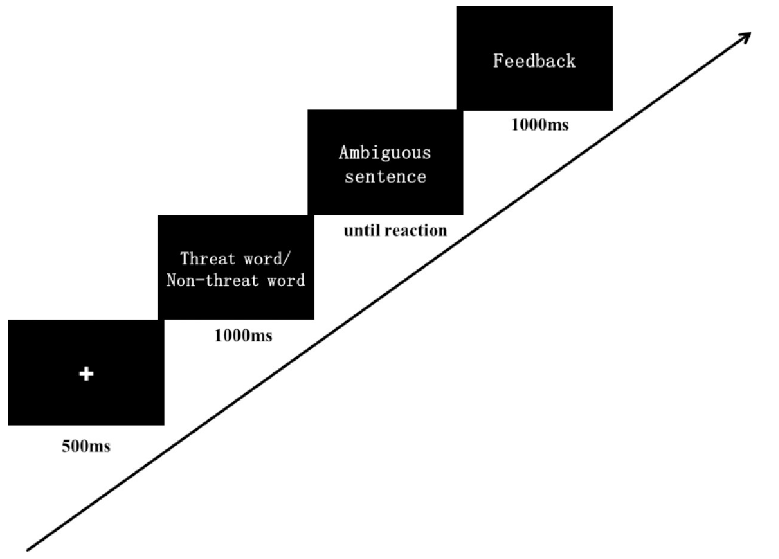
Fig 4. Sequence of event in the IMP